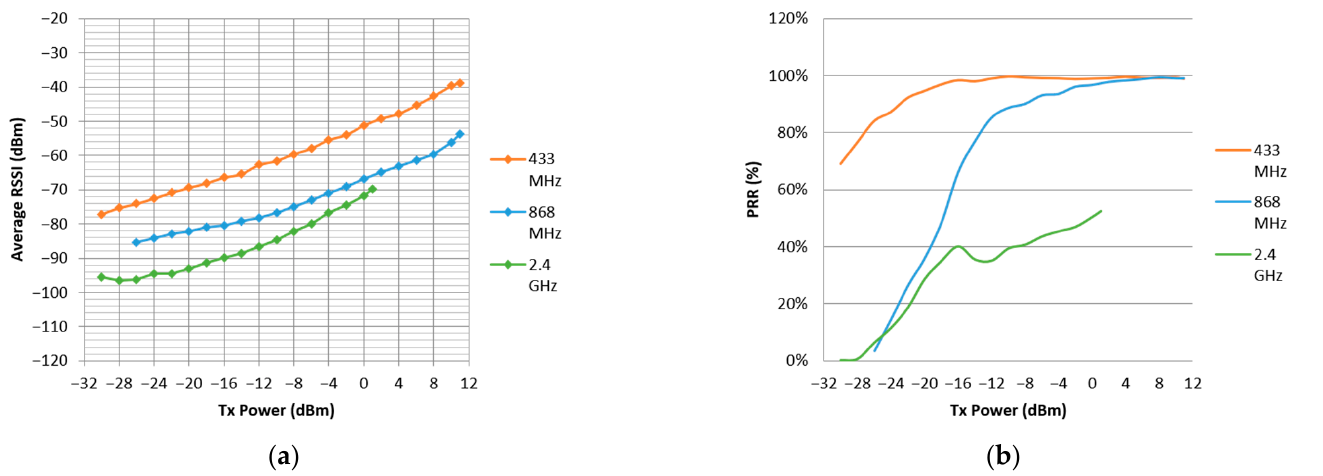
Figure 9. Performance metrics in the cycling scenario: ( a ) Average RSSI, ( b ) PRR.